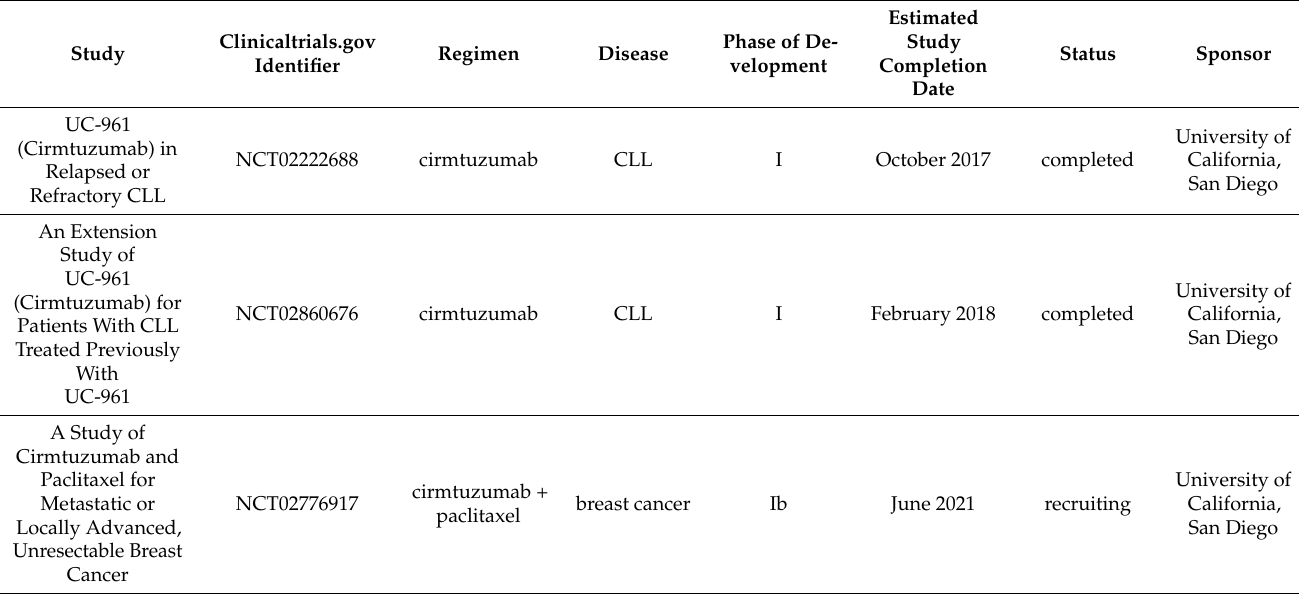
Table 2. Clinical trials with ROR1- and ROR2-targeting